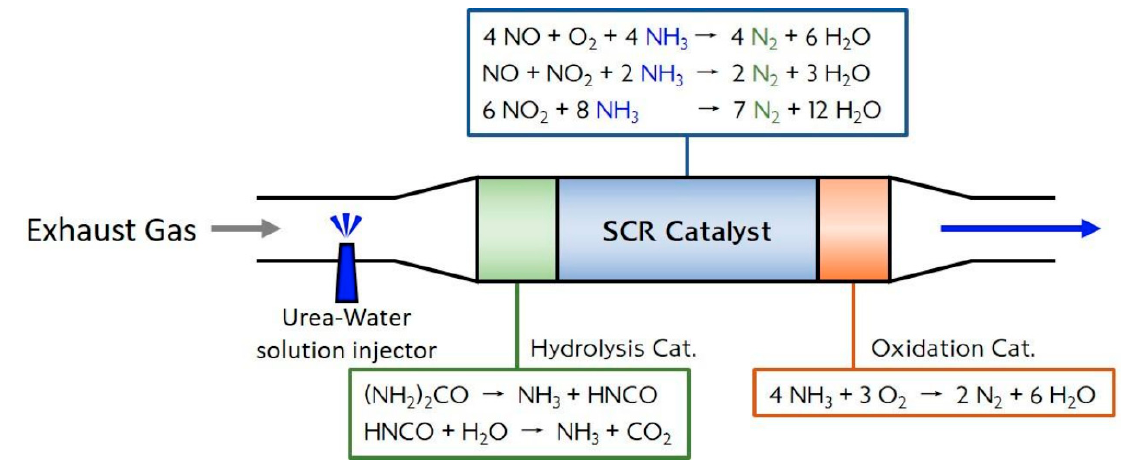
Figure 15. Schematic of the SCR system